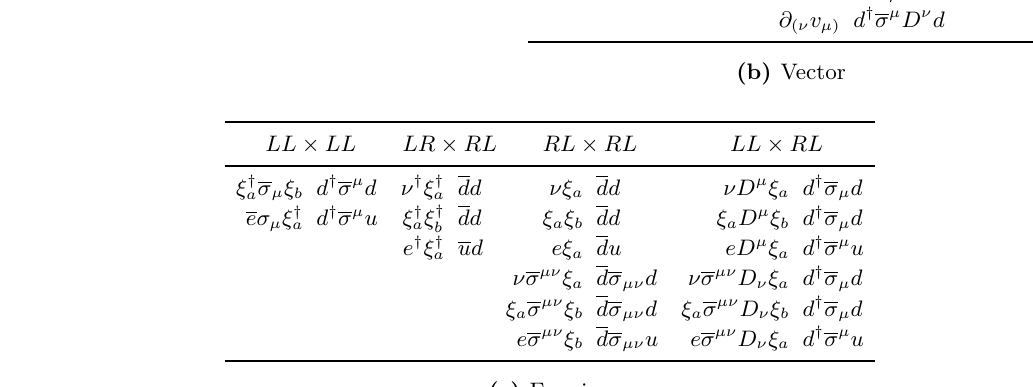
and their Hermitian conjugates are suppressed by factors of (4 π ) − 2 . The above sub-leading dimension seven operators are listed in table